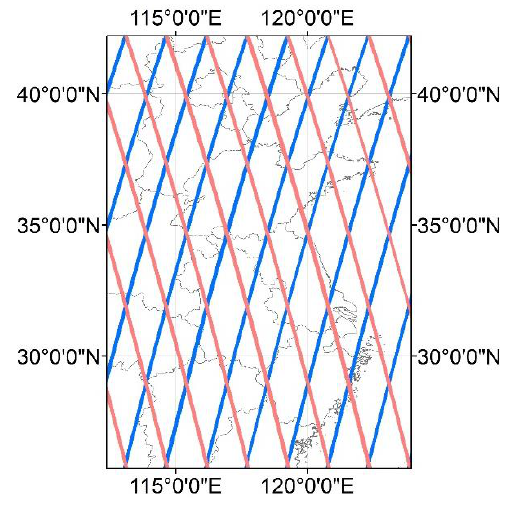
Figure 1. Satellite orbital distribution in the study area (red=daytime, blue=nighttime)